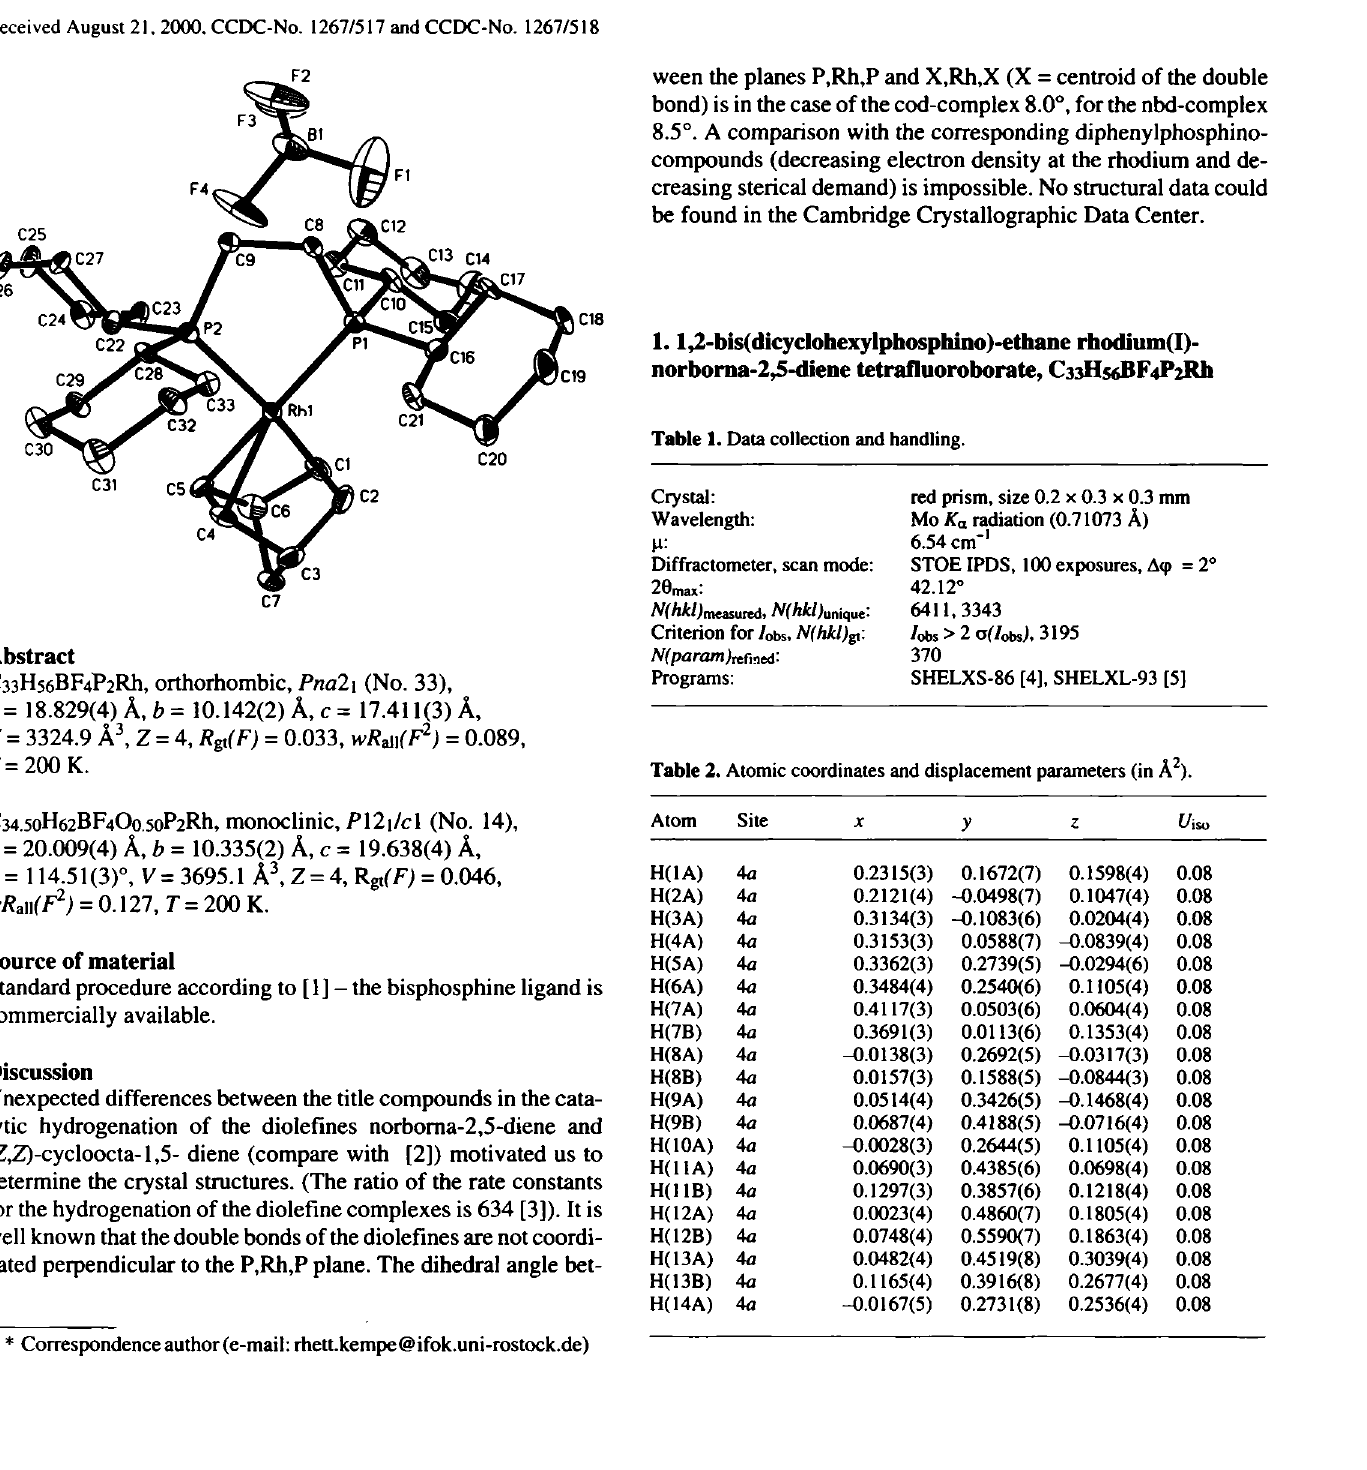
Table 2. Atomic coordinates and displacement parameters (in Ä 2